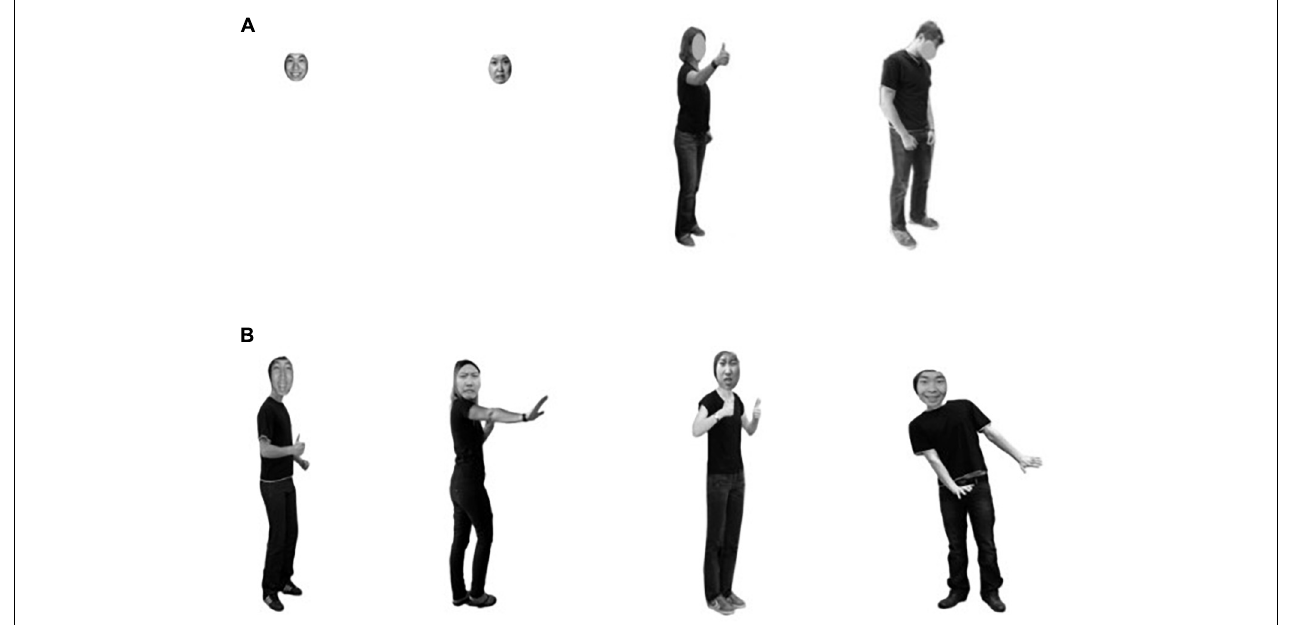
FIGURE 1 | Schematic diagram of experimental materials. (A) The pictures representing emotions separately for face and body presented are positive-face, negative-face, positive-body, and negative-body. (B) Four kinds of facial and bodily compound stimuli were produced in the experiment. From left to right, they are positive face–positive body, negative face–negative body, positive face–negative body, and negative face–positive body. (All experimental materials were edited with Adobe Photoshop CS6 to control the brightness and contrast).